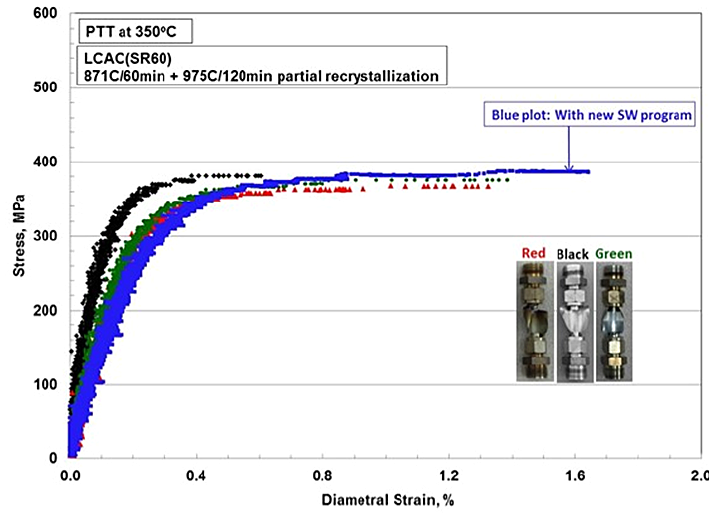
Fig. 3. Internally pressurized test of samples from a partially recrystallized LCAC Mo tube at 350 °